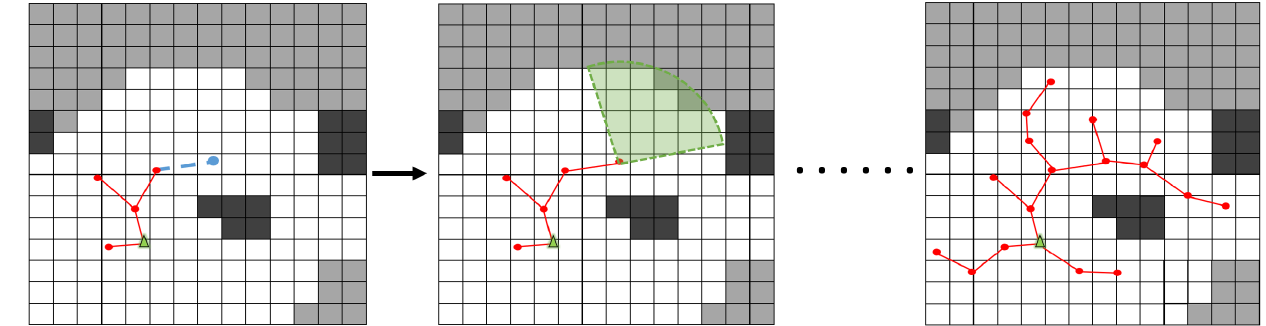
Figure 2. Roadmap is built as a living RRT. We keep the tree alive and maintain it through the whole exploration process. The green triangle represents the current state of the robot, while the green sector represents the FOV. The red lines represent the maintained roadmap, and the red dots represent the nodes. The blue point shows the position of the candidate, and the blue dotted line indicates that the collision detection result is free. The white, gray, and black grids represent free, unknown, and occupied space respectively.